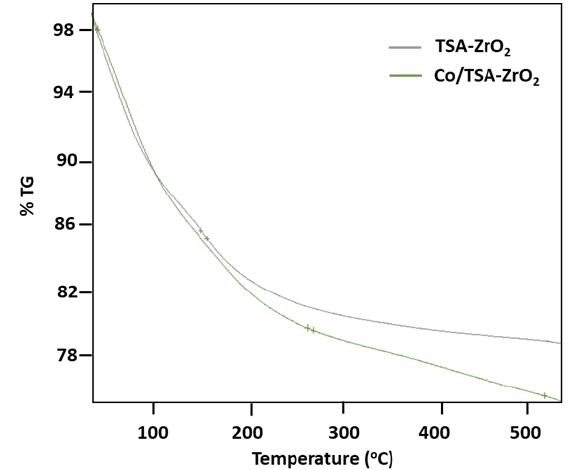
Figure 1. TGA of TSA-ZrO 2 and Co/TSA-ZrO 2 . The FT-IR of TSA, TSA-ZrO 2 , and Co/TSA-ZrO 2 are represented in Figure 2. All the synthesized materials showed a band in the region 3390–3370 cm − 1 for O–H stretching, and at around 1617 cm − 1 for H–O–H bending mode vibrations. TSA evinced major characteristic bands at 1017 cm − 1 υ as (Si-O a ), 976 cm − 1 υ as (W = O b ), 907 cm − 1 υ as (W–O c